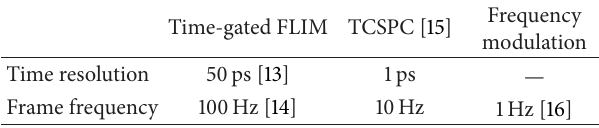
Table 1: Parameters comparison of different FLIM methods.